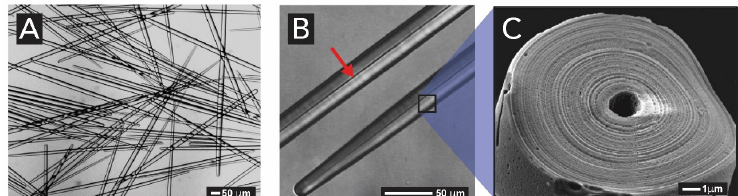
Figure 12. Isolated spicules from Tethya aurantia. ( A ) Optical micrographs of isolated spicules measuring 30 μ m in diameter and 2 mm in length and ( B ) its higher magnification image showing axial filaments running through the center of the T. aurantia spicules (arrow). ( C ) Scanning electron micrographs of a cross-section, showing the concentric circular siliceous deposits after removal of the preexisting axial filaments. Scale bars: (A–B) 50 μ m, (C) 1 μ m. Adapted from [93] with permission from John Wiley and Sons.